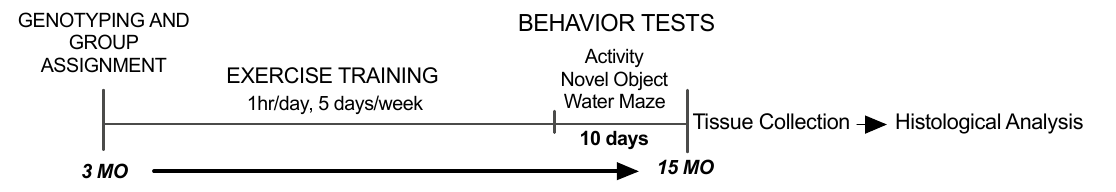
Figure 1. Experimental Design. Age of exercise training and order of behavior tests.